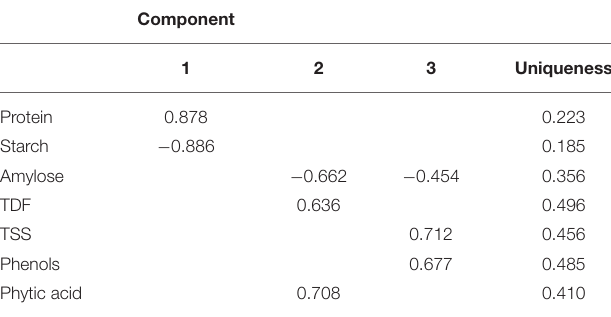
TABLE 3 | Component loadings for PCA with varimax